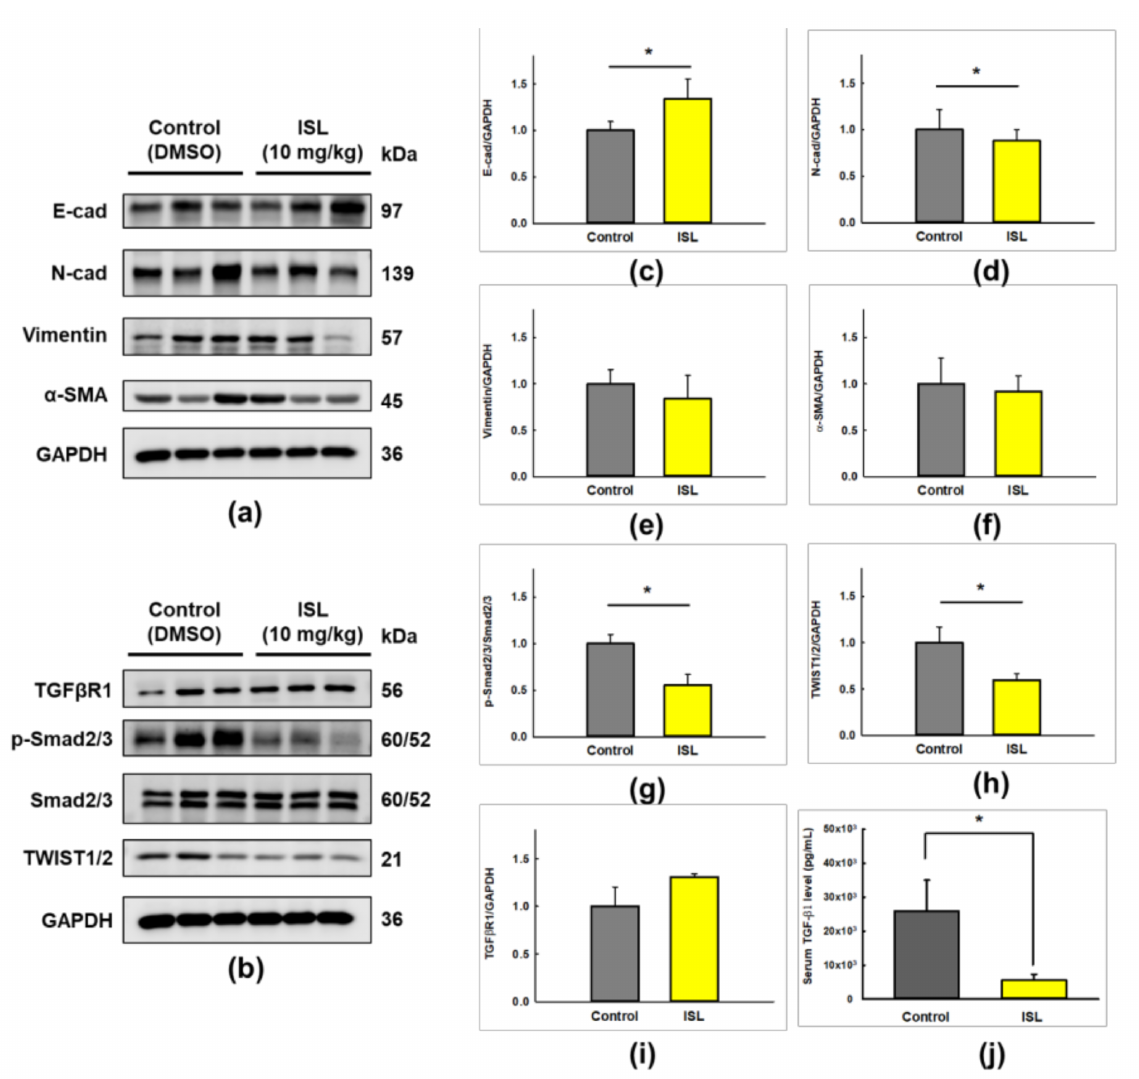
Figure 8. The effect of ISL on EMT related markers expression in the HEC-1A-LUC mouse xenograft model. Tumors were implanted into mice by intraperitoneal injection of HEC-1A-LUC cells (2 × 10 6 cells/100 µ L PBS), and the mice were injected intraperitoneally with ISL (10 mg/kg) or control (DMSO) every 2–3 days for 28 days. The protein expression of E-cadherin, N-cadherin, vimentin, α -SMA, TGF β RI, p-Smad2/3, Smad2/3, and TWIST1/2 in whole cell extracts from tumor tissues were determined by western blotting ( a , b ). Each target protein was normalized to GAPDH and protein quantification was shown in bar graph ( c – i ). The serum level of TGF- β 1 was analyzed by a commercial ELISA kit ( j ). Data were expressed as the mean ± SD ( n = 3). * p < 0.05 versus the